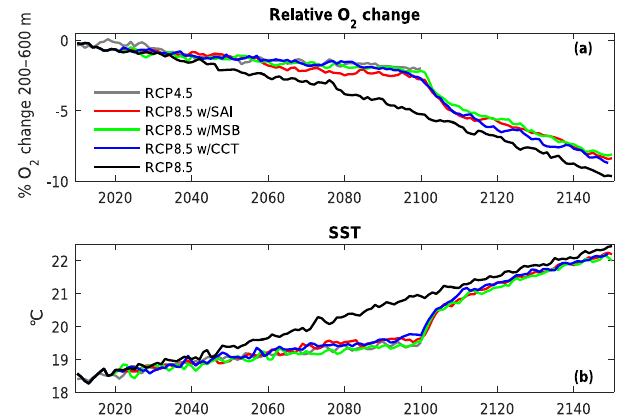
Figure 1. Time series of global average change in (a) oxygen con- tent at 200–600m of depth (%) and (b) SST ( ◦ C). The oxygen change is relative to the 1971–2000 average in the historical